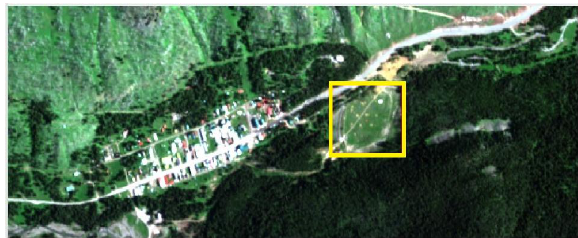
Figure 1. The true colour composite of the HyMap image. The yellow region represents location of the targets